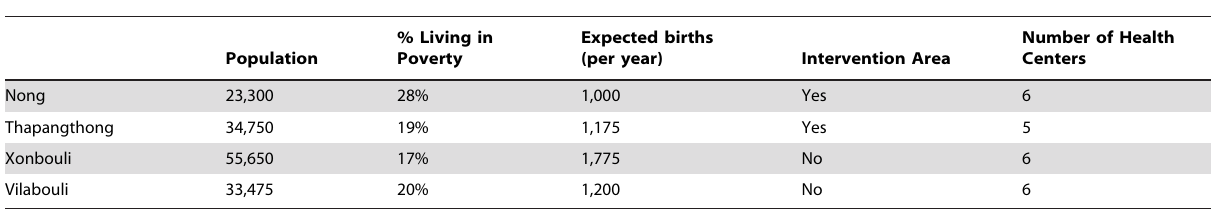
Table 3. Descriptive